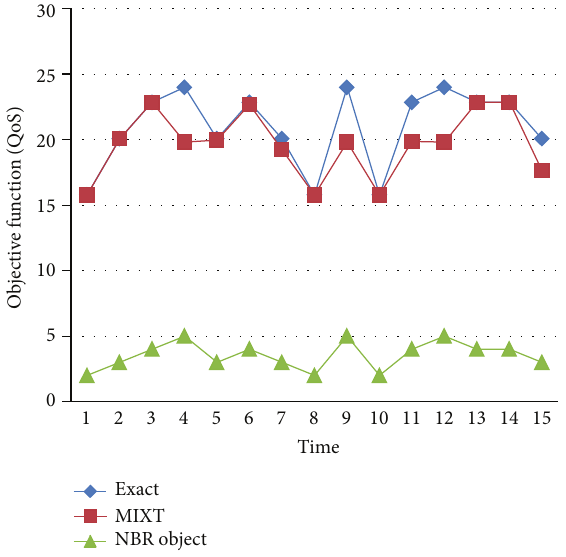
Figure 18: Number Object/QoS variation for exact and selected method.